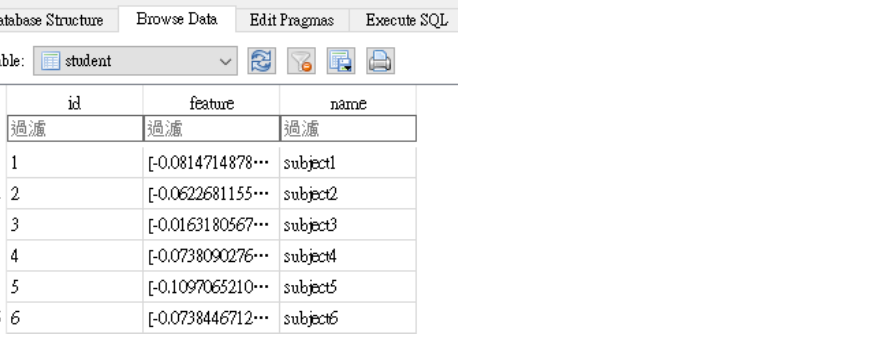
Figure 5. SQLite databases after JSON serialization which was sipped from the SQLite software results The meaning of 過濾 is filter.